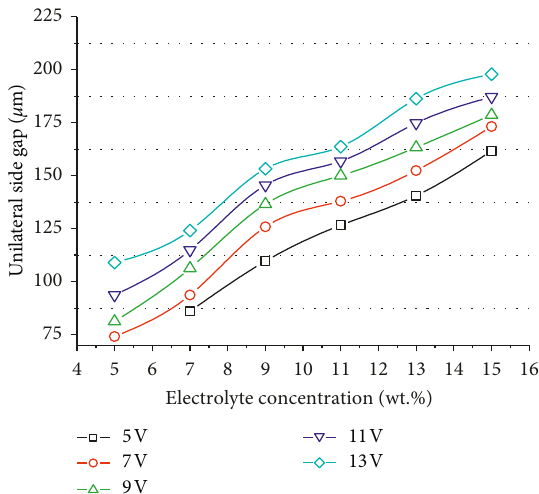
Figure 7: Variation curves of the unilateral side gap Δ s with electrolyte concentration.